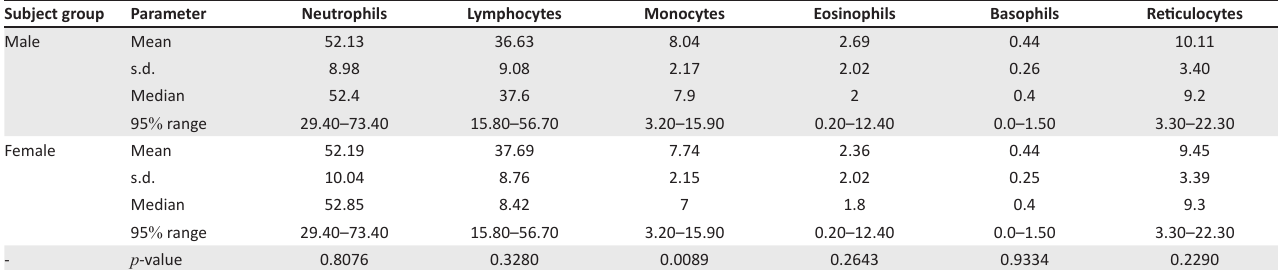
TABLE 6: Means, medians and 95th percentile reference intervals of white blood cell subset percentages for 261 HIV-negative adults in